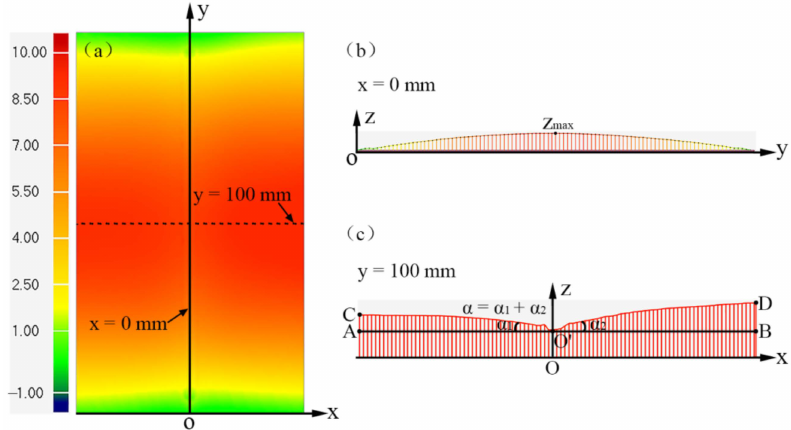
Figure 5. Deformation characteristics of µ FSW: ( a ) overall anti-saddle deformation, ( b ) longitudinal bending deformation, and ( c ) transverse angular